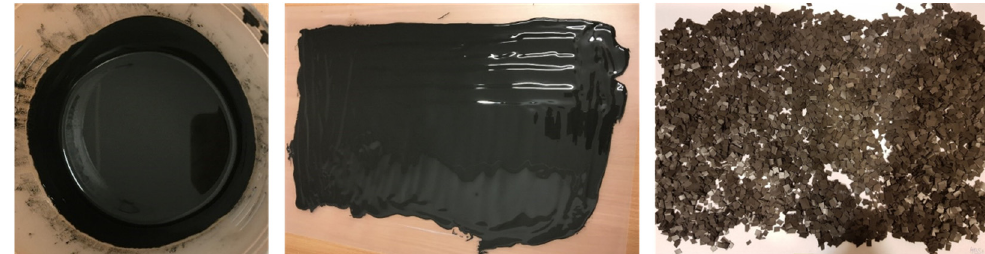
Figure 4. Composites at subsequent stages of fabrication: mixture of polymer, solvent and nickel powder after stirring ( left ), slurry after pouring on the foil ( middle ), final composite cut into granules ( right ).